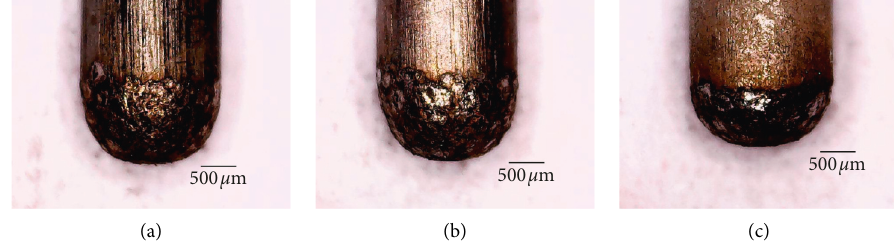
Figure 8: Shape changes of molybdenum composite tools. (a) Common tool. (b) Nickel-coated composite tool. (c) Diamond-nickel-coated composite tool.